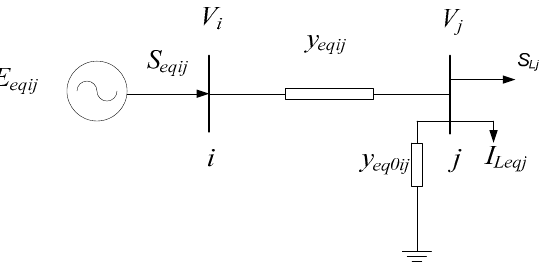
Figure 1. Single-port equivalent depending on component peculiarity representation and sensitivity persistence for bus j.